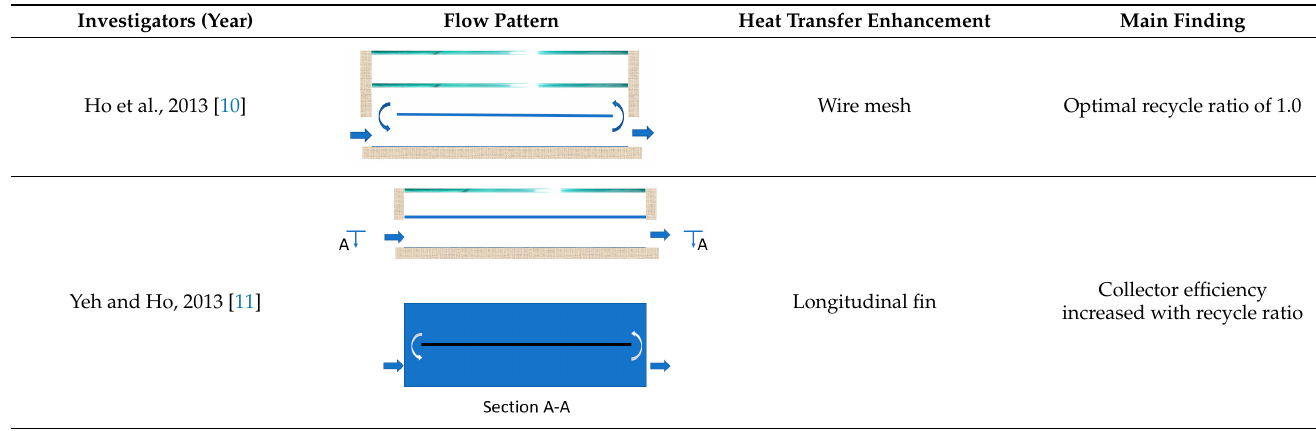
Table 1. Summary of multi-pass SAH studies on flow pattern change.